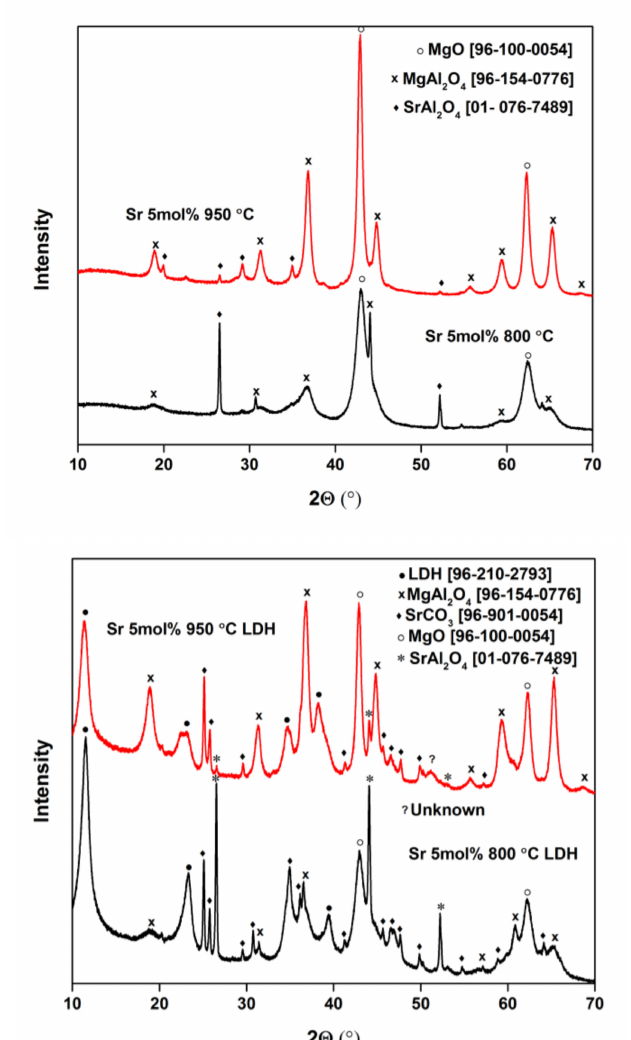
Figure 4. XRD patterns of mixed metal oxides (MMO) obtained by heating the Mg 1.95 Sr 0.05 / Al 1 precursor gels at 800 ◦ C and 950 ◦ C ( top ) and reconstructed Mg 1.95 Sr 0.05 / Al 1 LDHs ( bottom